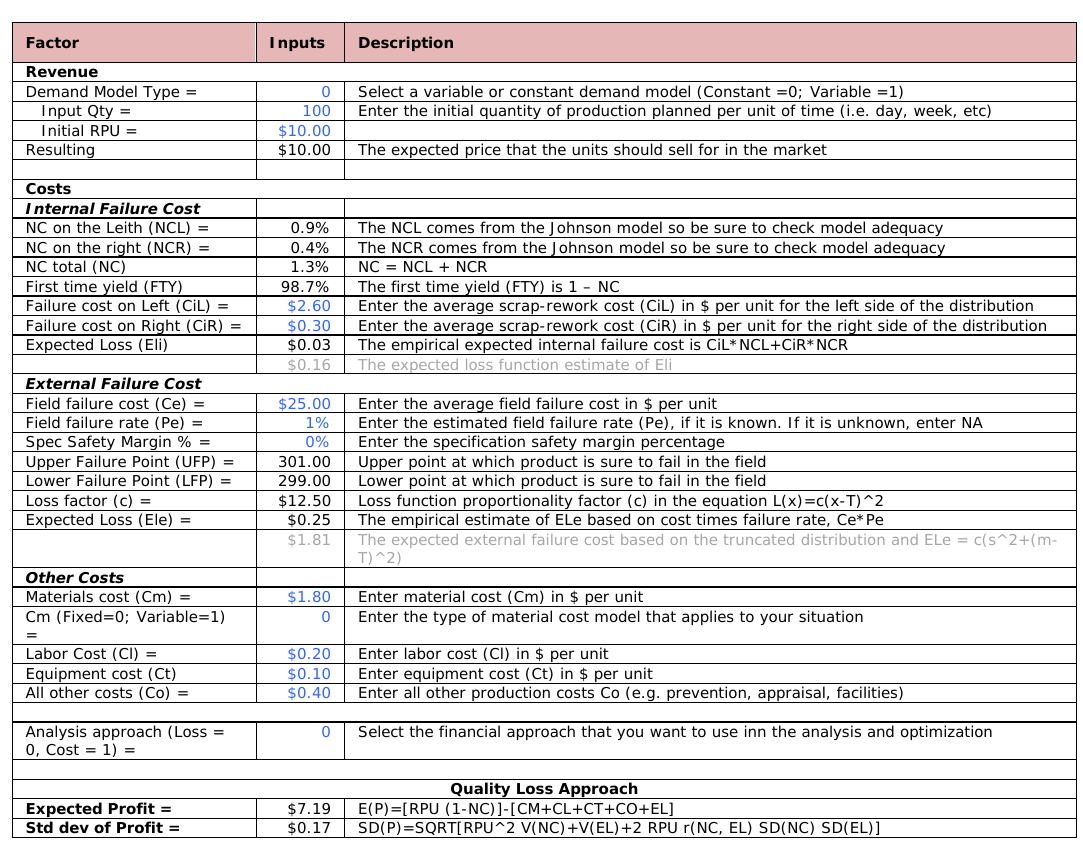
Table 1. “Pipe Grinding Business